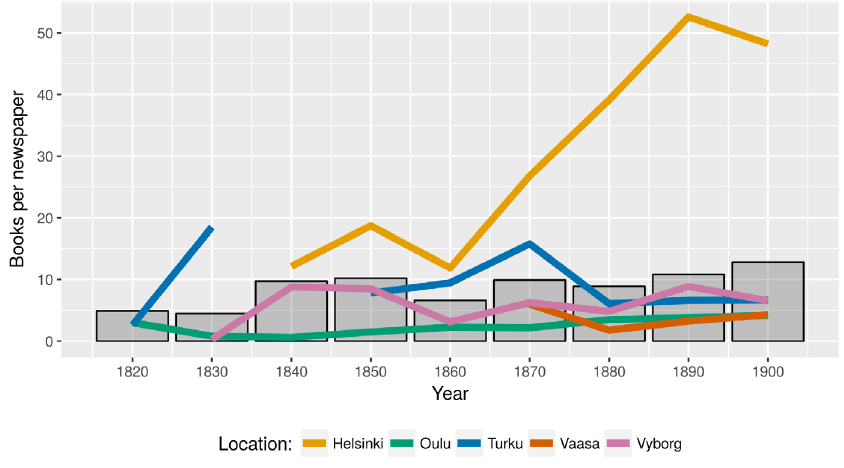
Fig. 12 The numbers of Finnish-language books published per decade at selected locations from 1820 to 1900, divided by the respective numbers of Finnish- language newspaper titles: the bars show the national average of Finnish- language books published per Finnish-language newspaper title42